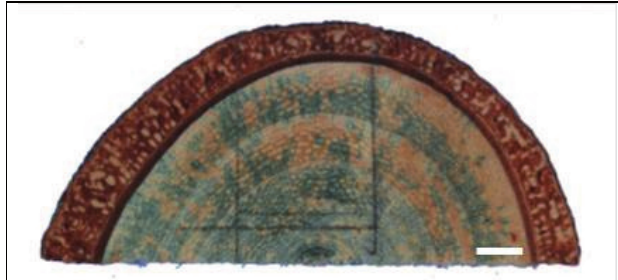
Fig. 1: Staining of the water conducting xylem in the stem of a three-year- old maté plant (phenotype “Amarelinha”) with methylene blue. Scale bar = 2 mm.